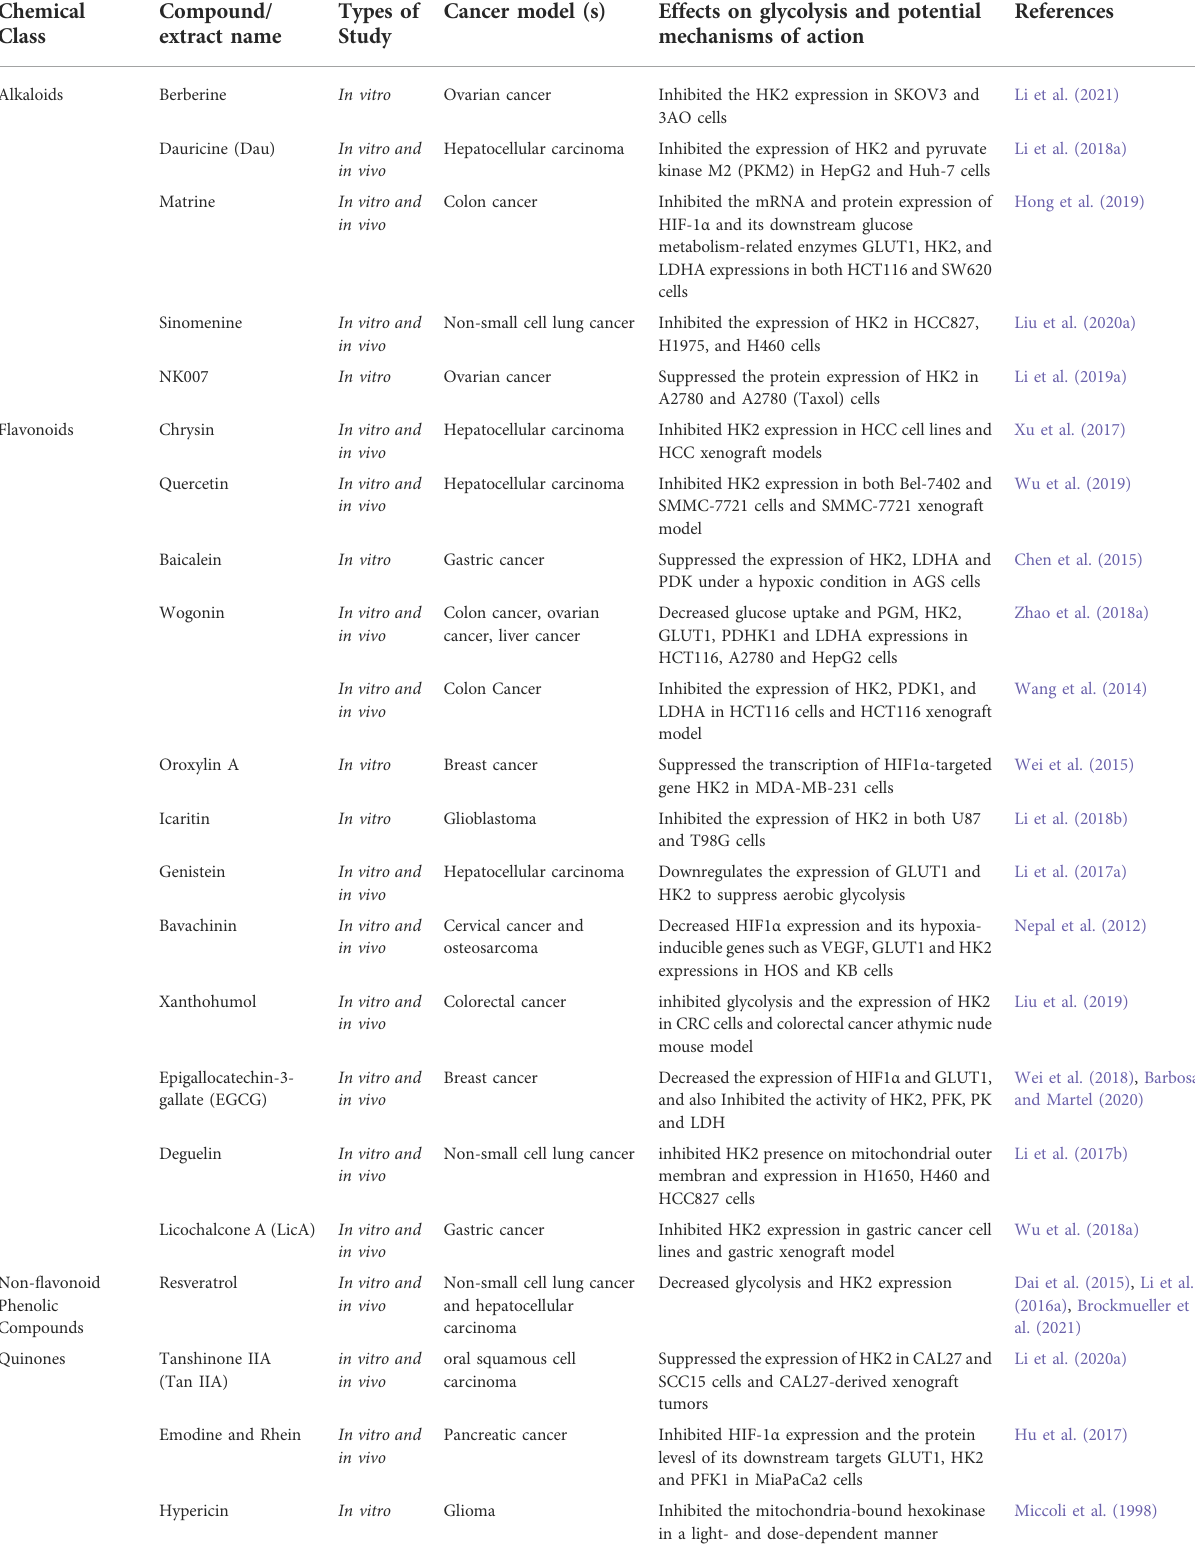
TABLE 1 Natural compounds target hexokinase